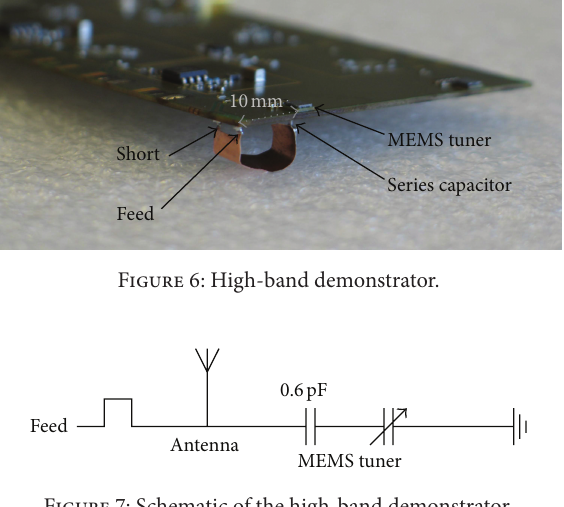
Figure 7: Schematic of the high-band